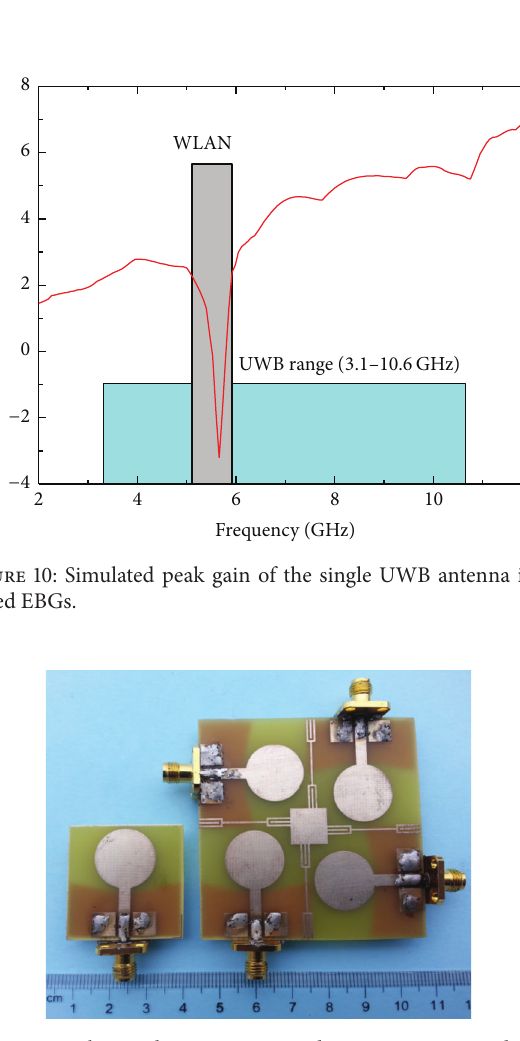
Figure 11: Fabricated UWB integrated EBGs antenna and final MIMO antenna.